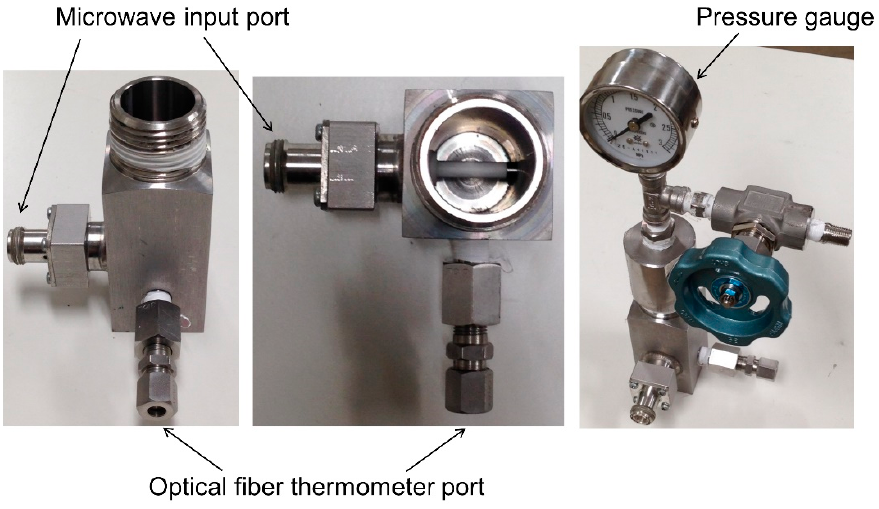
Figure 3. Photographs of the developed cylindrical applicator with the microwave irradiation probe. The optical fiber thermometer port was attached orthogonally to the microwave input port on the side of the applicator. The pressure gauge was mounted to the top of the applicator to maintain the internal pressure.